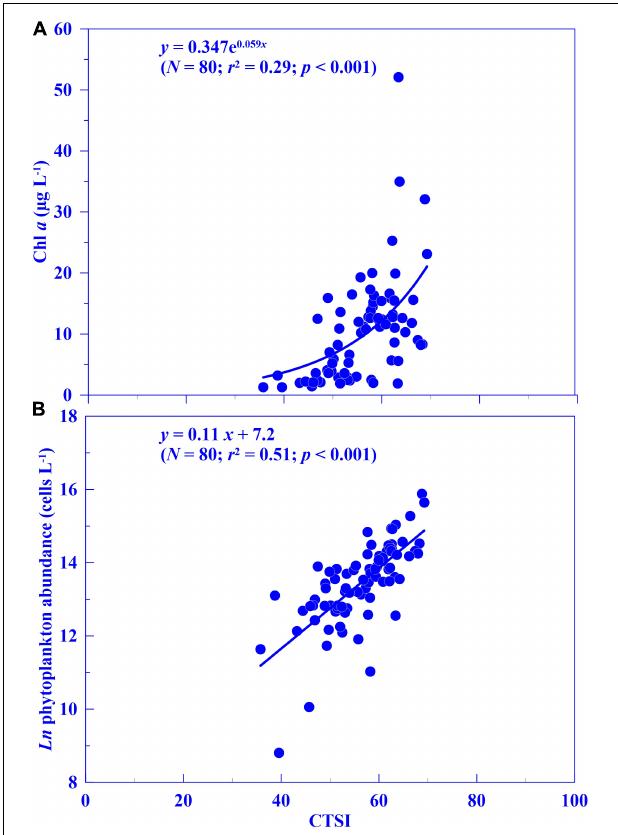
FIGURE 5 | Correlation analysis of (A) chlorophyll a (Chl a ) concentration and (B) phytoplankton abundance against the Carlson Trophic State Index (CTSI, Carlson, 1977) in Dapeng Bay (2015–2016).